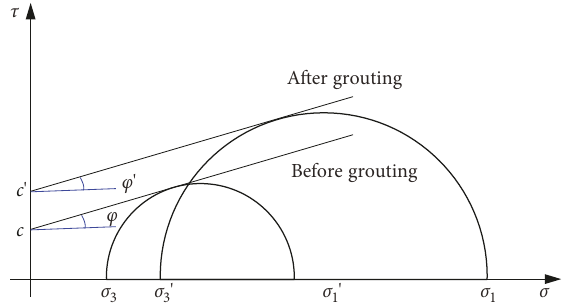
Figure 13: Failure mechanics condition of rock mass before and after cable